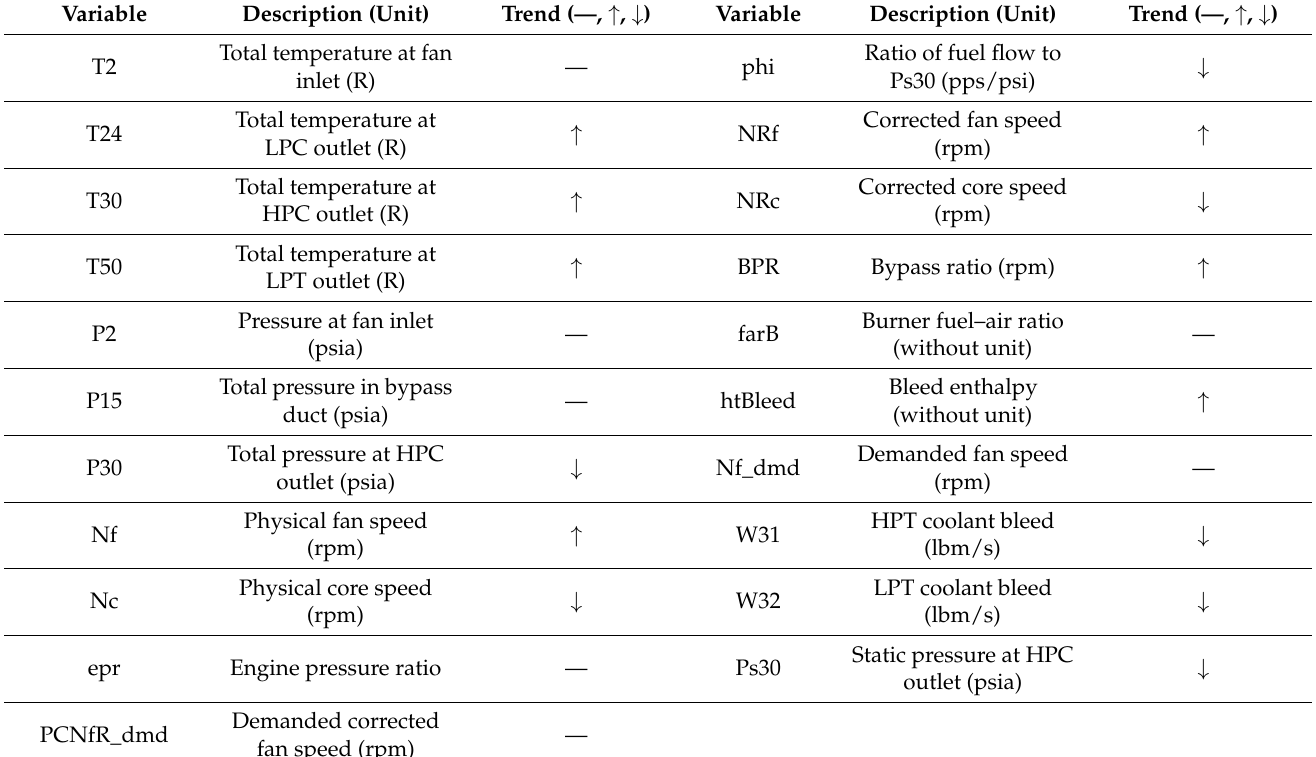
Table 1. Variable descriptions of the HPC fault